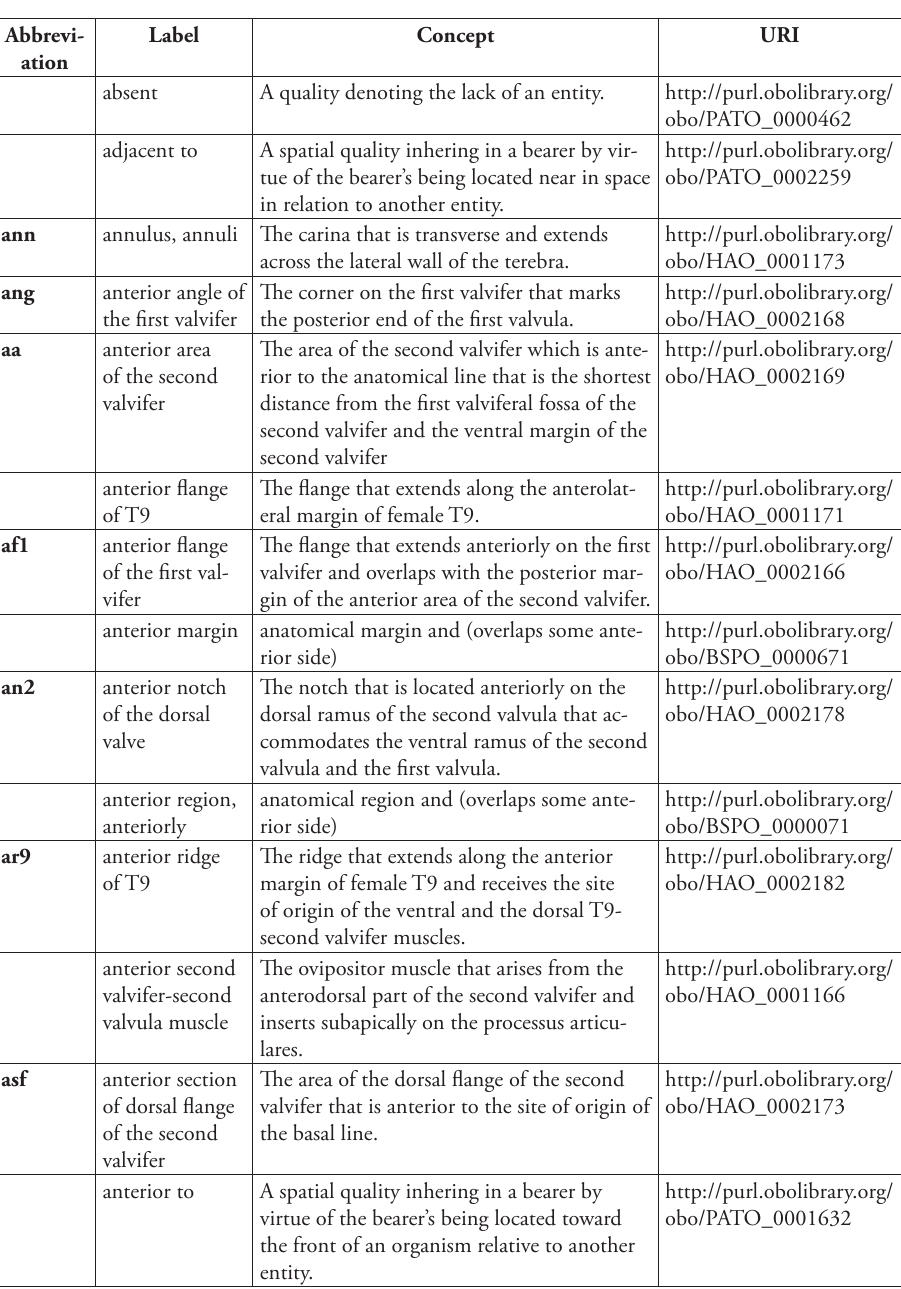
Anatomical terms used, cross-referenced to an ontological (formal) definition (Hymenoptera Anatomy Ontology; URI = Uniform Resource